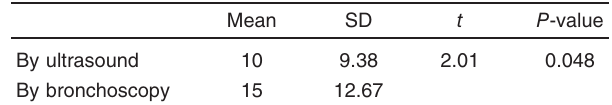
Table 3 Ultrasonographic detection of tracheal and esophageal intubation